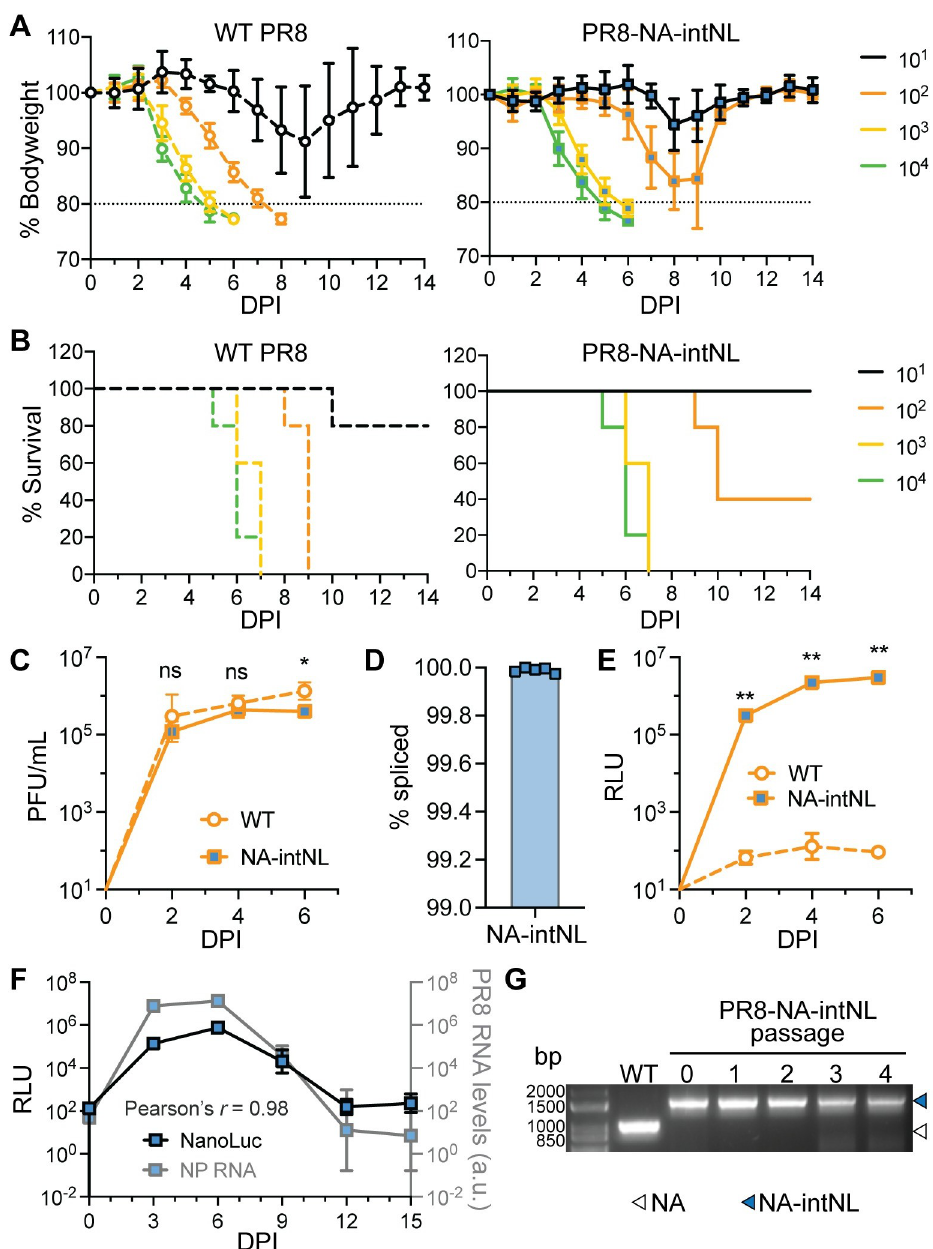
Fig 5. IAVs harboring introns with luciferase genes cause disease in a mouse model. (A) Relative bodyweights of WT PR8 (left) and PR8-NA-intNL (right) virus infected C57BL/6J mice (age matched, 6–12 weeks, female) (mean with SD, n = 5 mice per group). DPI, days post-infection. (B) Survival of WT PR8 (left) and PR8-NA-intNL (right) virus infected BL/6 mice (n = 5 mice per group). (C) Lung viral titers from WT PR8 and PR8-NA-intNL virus infected (100PFU) BL/6 mice, measured using plaque assays (mean with SD, n = 5 mice per group, unpaired Student’s t-test relative to WT). (D) PR8 segment 6/NA-intNL mRNA splicing rates from PR8-NA-intNL virus infected (100PFU, 4d) BL/6 mouse lungs, measured using two-step RT-qPCR (mean with SD, n = 5 mice per group). (E) Luciferase levels from WT PR8 and PR8-NA-intNL virus infected (100PFU) BL/6 mice lungs (mean with SD, n = 5 mice per group, unpaired Student’s t-test relative to WT). (F) Luciferase and PR8 NP RNA levels from PR8-NA-intNL virus infected (10PFU) BL/6 mouse lungs (mean with SD, n = 3 mice per group, Pearson correlation coefficient). Arbitrary units (a. u.) determined relative to 18S. Background levels of detection from uninfected mice are shown at 0DPI. (G) RT-PCR of WT PR8 virus (white) and PR8-NA-intNL virus (blue) segment 6/NA passages 0 to 4 from serial infections (1000PFU, 3d passages) in BL/6 mouse lungs (representative of three independent experiments). For all panels: � P < 0.05, �� P < 0.001 and ns = not significant.